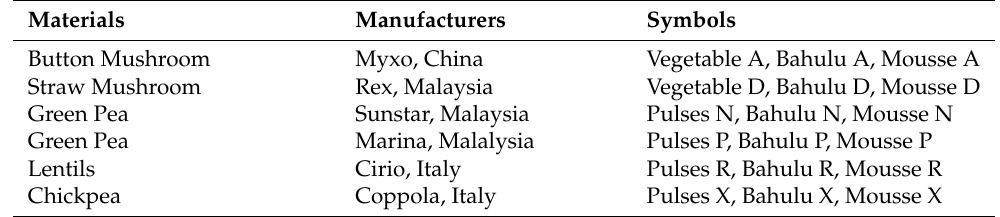
Table 1. Canned pulse and vegetable liquid samples.